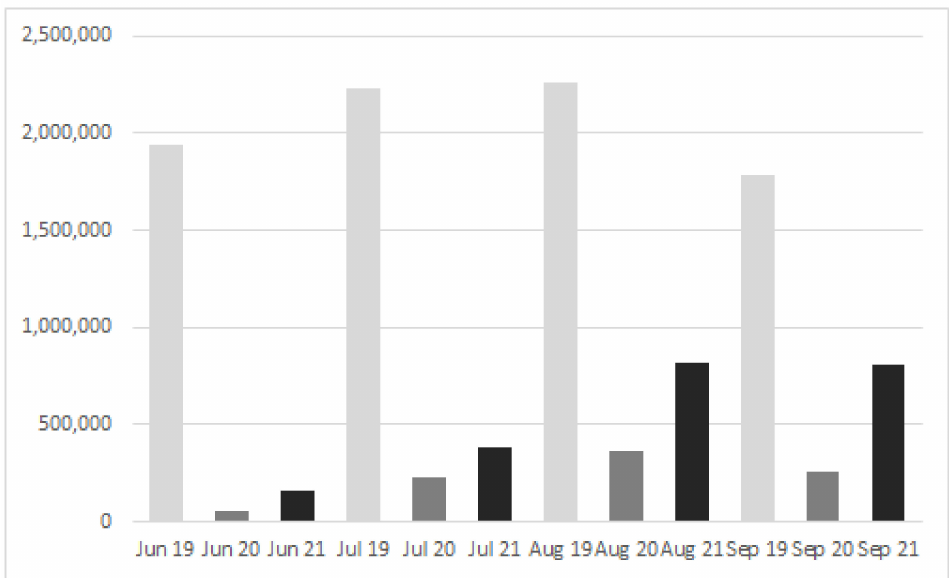
Figure 4. Overseas arrivals in Ireland in the summers of 2019, 2020 and 2021 (data source: